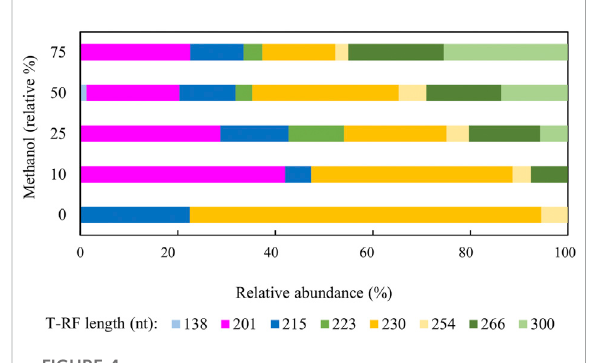
FIGURE 4 Terminal restriction enzyme fragment length polymorphism (T-RFLP) analysis (HaeIII digests) of ampli fi ed 16S rRNA genes of planktonic bacterial communities in the sul fi dogenic bioreactor fed with different combinations of methanol and glycerol. Shades of blue represent known sulfate-reducing Firmicutes (138 nt, Peptococcaceae CEB3; 215 nt, D. acididurans ), shades of yellow represent non-sul fi dogens (230 nt, Actinobacterium AR3; 253 nt, At. ferrooxidans ), shades of green represent bacterial clones identi fi ed as probable non-sul fi dogens, while the magenta bars represent clone SRB7, which was positively identi fi ed as a strain of the sulfate-reducer Dv. desulfuricans .